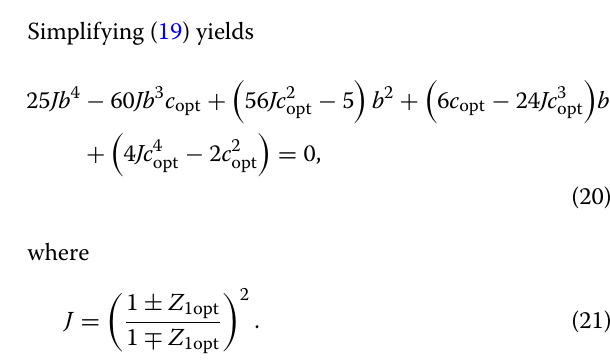
c d Fig. 3 Symmetric mean absolute percentage error (left column) and edge geometry (right column) generated by 3 × 3 chamfer mask. a Euclidean √ √ 2. b Euclidean weights, a = 1, b = 2, and r = 1 c . Our weights, a = 0.9612 and b = 1.3593 d . Our weights, a = 0.9612, weights, a = 1 and b = b = 1.3593, and r = 1